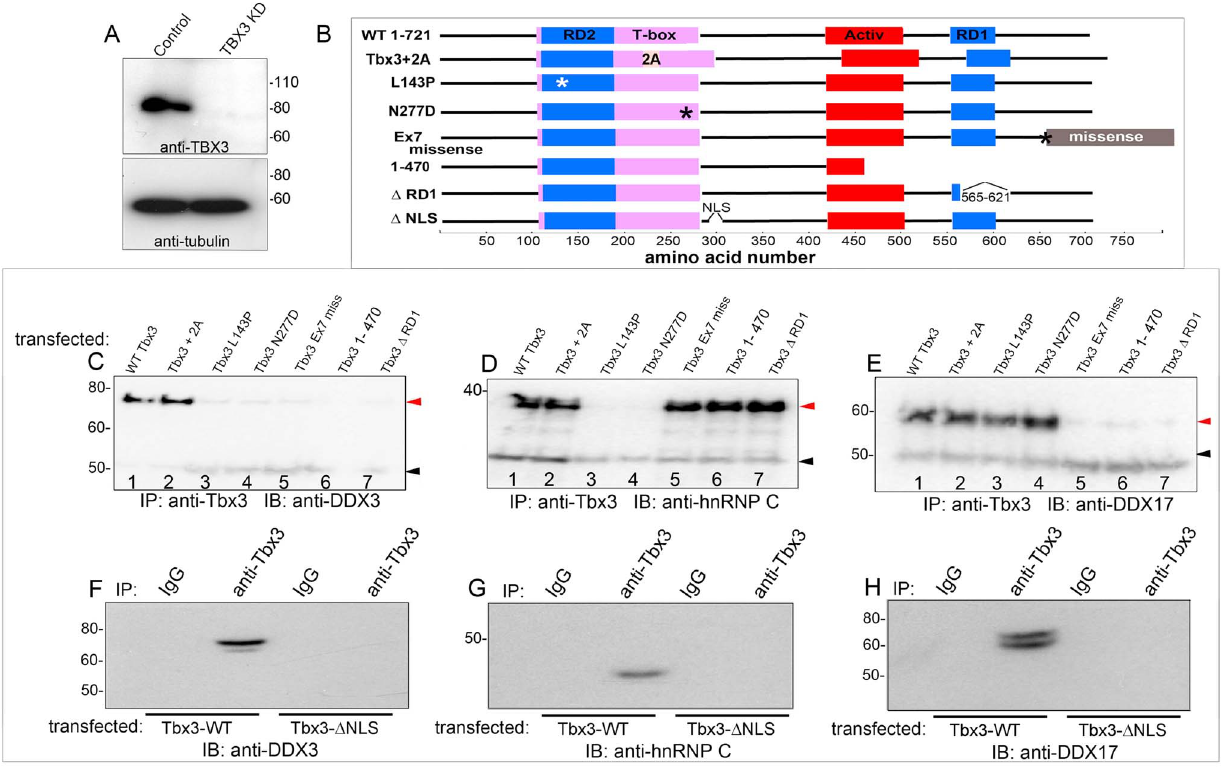
Figure 2. Different Tbx3 protein domains are required for protein-protein interactions. Stable retroviral mediated knockdown of endogenous TBX3 in HEK293 cells followed by transfection of wild type and Tbx3 mutant proteins as diagrammed. Lysate IPs were assayed by IB with antibodies noted at bottom of panels. A) Immunoblot of control versus TBX3 shRNA (KD) lysates. B) Schematic of Tbx3 mutant proteins. Confirmation of expression and successful IP of overexpressed Tbx3 proteins is presented in Figure S2. C–E) Interactions of mutant Tbx3 proteins with DDX3, hnRNP C, and DDX17 tested by IP and western blotting. F–H) Tbx3 NLS is required for Tbx3 interactions with DDX3, DDX17 and hnRNP C. red arrowheads: interacting proteins; black arrowheads: